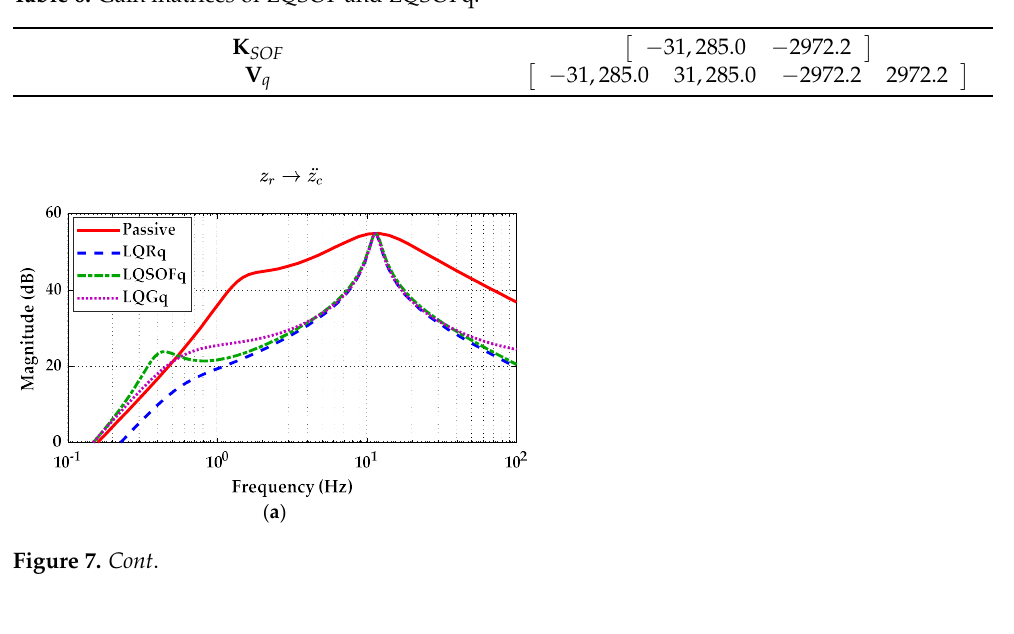
( b ) ( c ) Figure 7. Frequency responses from the road profile z r to each output for the quarter-car model. ( a ) Vertical acceleration of the sprung mass; ( b ) Suspension stroke; ( c ) Tire deflection. Figure 8 shows the frequency responses of each output from the road profile z r 1 with the FC model for each controller. As shown in Figure 8, the relationship between LQRq and LQGq given in Figure 7 is nearly identical to that of LQRfq and LQGfq. In other words, the performance of LQGfq becomes worse than LQRfq below 4 Hz and above 40